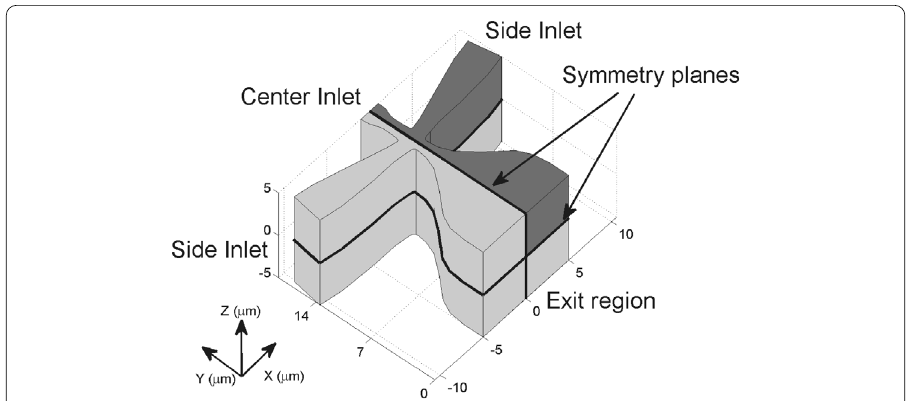
Figure 1 Schematic representation of the microfluidic mixer geometry. The region depicted in dark gray corresponds to the domain (cid:2) 3 D , q . The wide solid black lines highlight the geometry’s symmetry